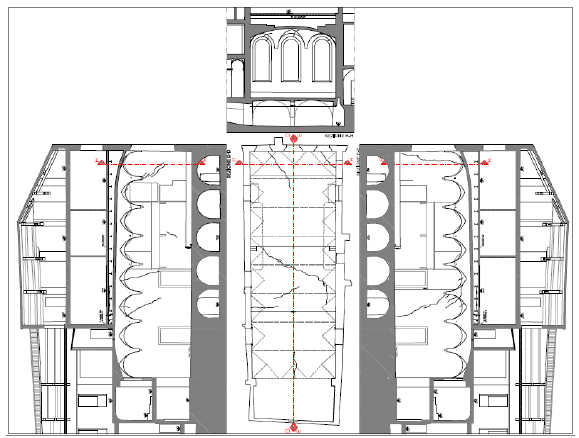
Figure 3. Scheme of the crack pattern of the great vaulted hall.